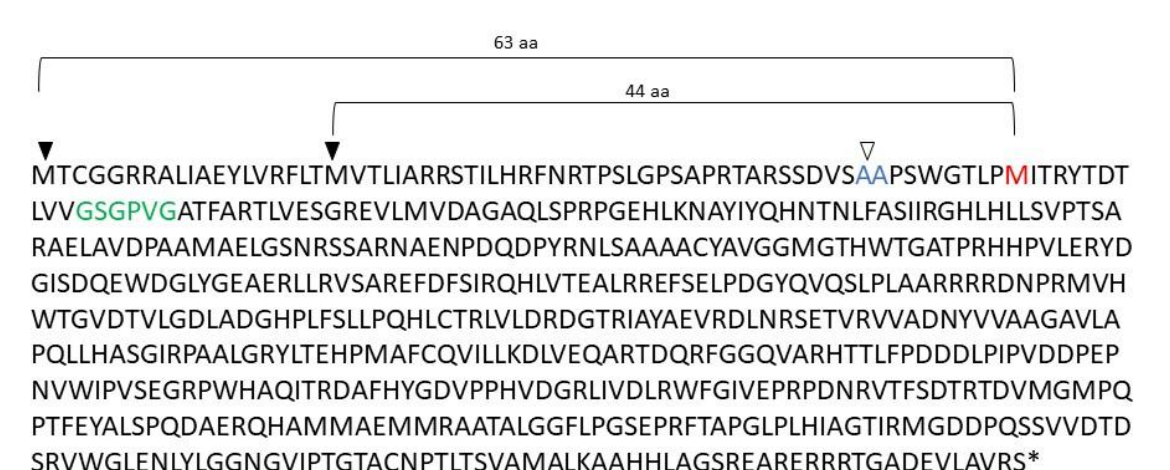
Figure 1. Results from ORF Finder showing two Methionine (M) in frame in the upstream region (filled triangles), followed by the previously annotated start codon (M in red). The putative cleavage site is shown in blue with an open triangle. The Rossman fold motif is shown in green.